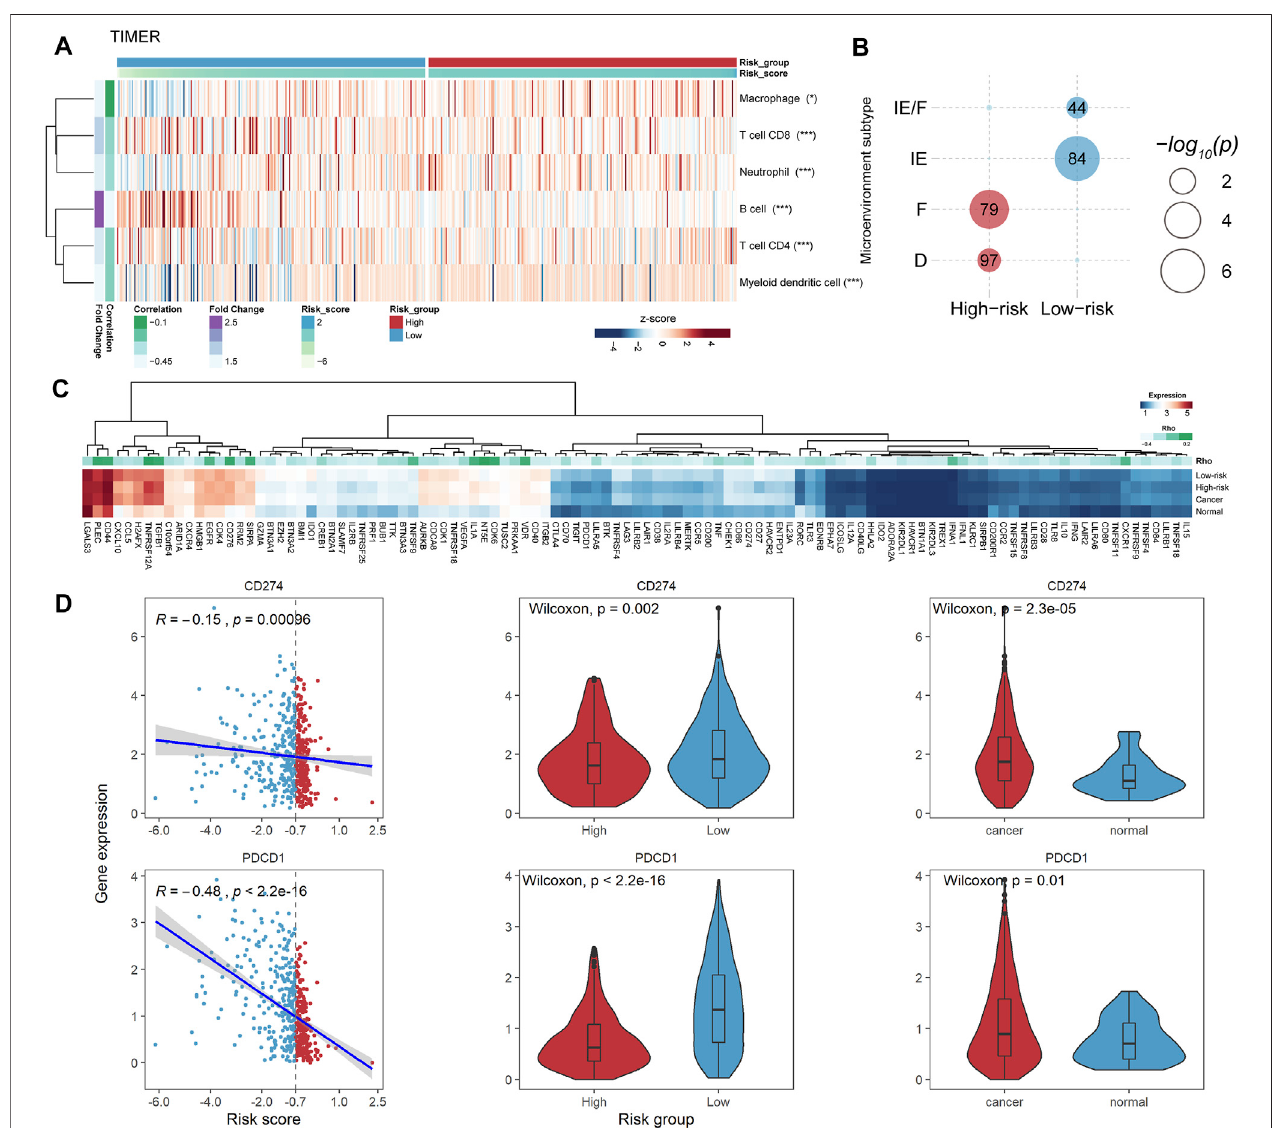
FIGURE 5| PFLS-risk groups were associated with the tumor immunemicroenvironment. (A) Heatmap showing the tumor immune cell in fi ltration levels assessed by TIMER. The Spearman ’ s correlation signi fi cance between cell abundance and the risk score was also computed for each cell shown on the right (* p < 0.05, ** p < 0.001, and *** p < 0.0001). (B) Bubble plot showing the signi fi cantenrichment between HNSCC microenvironment subtypes and riskgroups. (C) Heatmap showing the expression levels of PFLS-related ICPs. D. CD274 and PDCD1 were closely associated with the PFLS risk score. * p < 0.05, ** p < 0.001, and *** p < 0.0001 as calculated using the (B) accumulative hypergeometric distribution, (C) Spearman ’ s correlation test.